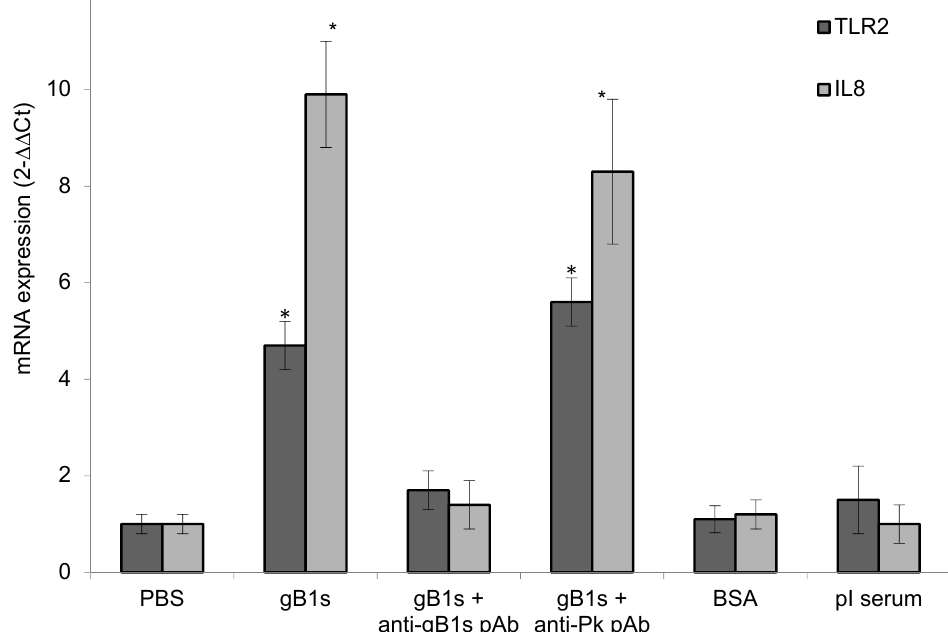
Figure 3. TLR2 and IL8 mRNA expression. Corneal epithelial cells were treated with 125 ng of gB1s alone or gB1s pre-treated with anti-pK pAb or gB1s pre-treated with anti-gB1s pAb or PBS, BSA, and pre-immune (pI) rabbit serum as control samples. For each group n = 3. Gene expression was expressed as 2 − ∆∆ Ct normalized to PBS control. Results were expressed as means ± SD from three different experiments and statistically analyzed by a one-way ANOVA test, followed by Tukey’s HSD. Differences in groups and treatments were considered significant for p <0.05. * p < 0.05 vs PBS control.